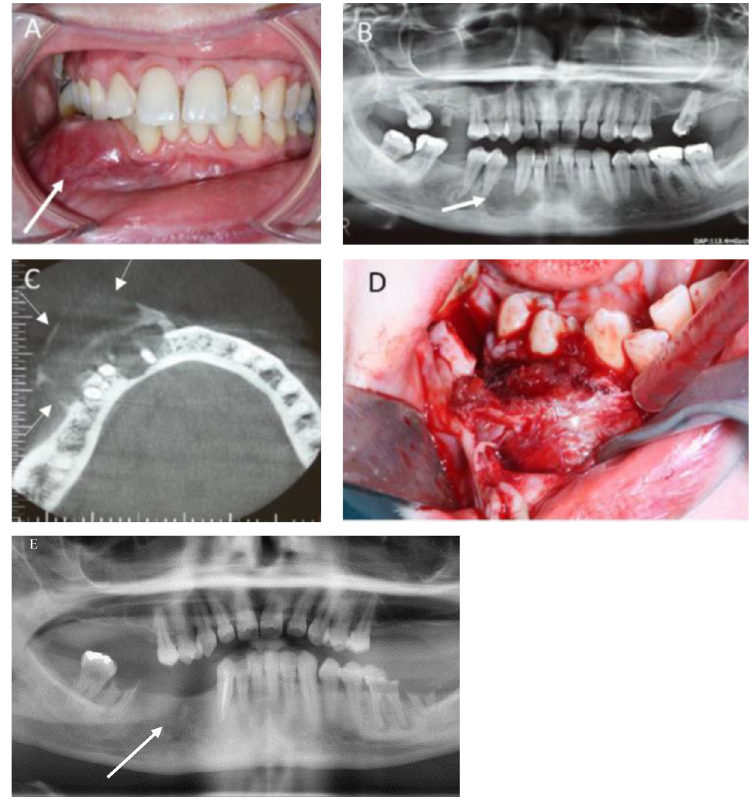
Fig. 1. (A) Intraoral view showing a lower right vestibular swelling. (B) Orthopantogram showing the lesion at the apex of tooth 43. (C) Axial section of the cone-beam computed tomography showing the vestibular extension with a blister and perforation of the cortex and the partitions of the lesion. (D) Surgical image showing the tumorous nature of the lesion. (E) Orthopantogram of the patient 8 years after the procedure shows reossi fi cation of the site. No recurrence has